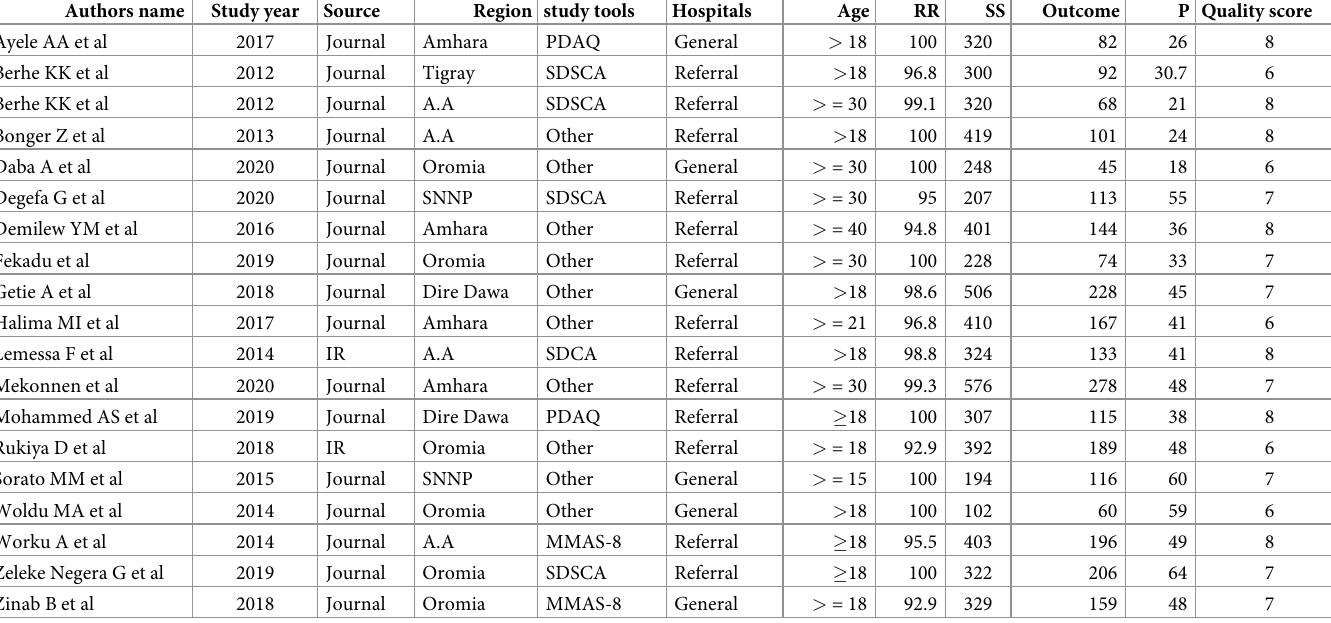
Table 1. Descriptive summary of 20 studies included in the meta-analysis of the proportion of dietary adherence among type 2 diabetes population in Ethiopia from